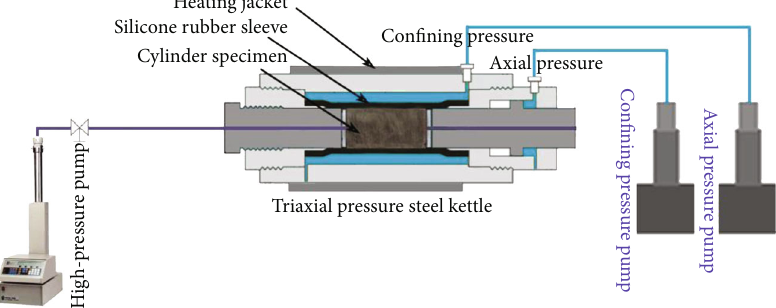
Figure 7: Schematic diagram of the hydraulic fracturing experimental device.